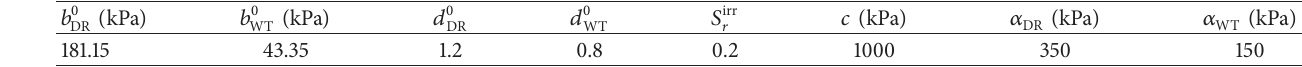
Table 3: Hydraulic parameters of Pearl